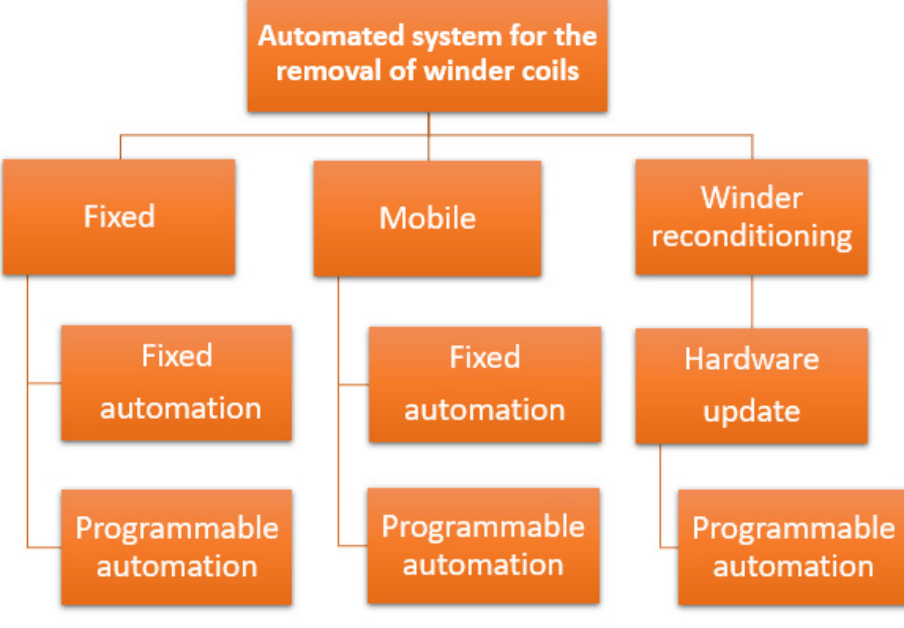
Figure 3. Brainstorming results.